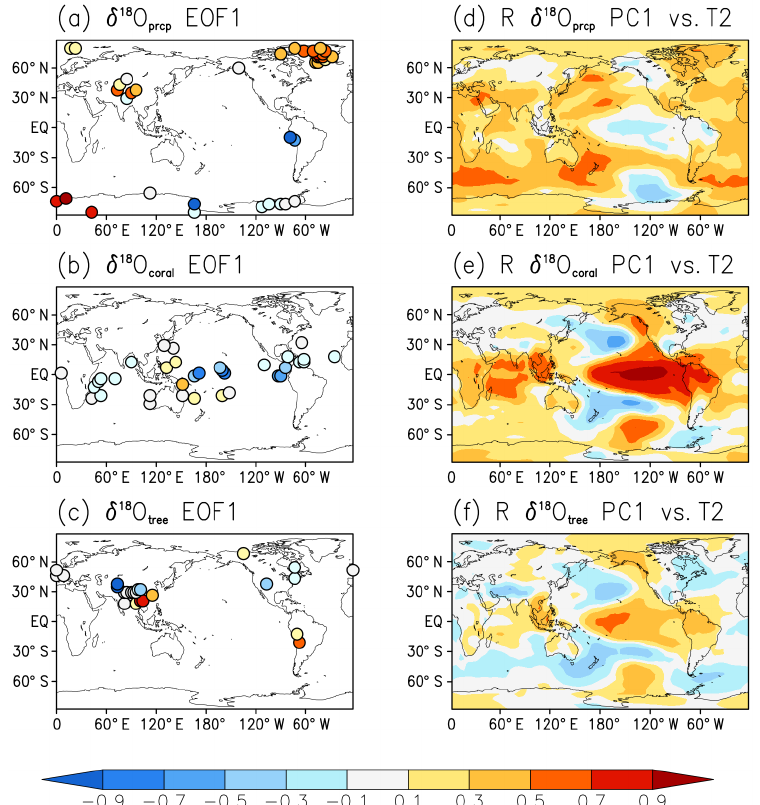
Figure 4. First mode of EOF and the correlation between PC1 and temperature for (a, d) ice cores, (b, e) corals, and (c, f) tree-ring